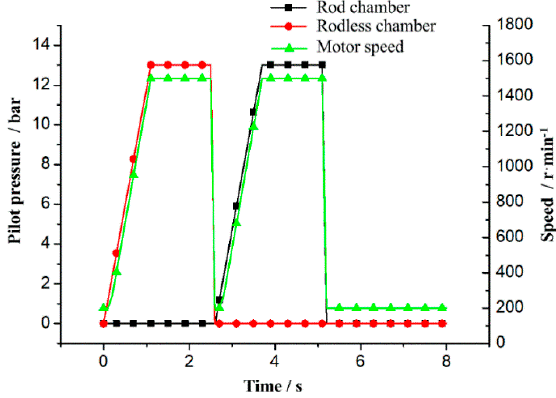
Figure 6. Curves of motor speed and pilot pressure.